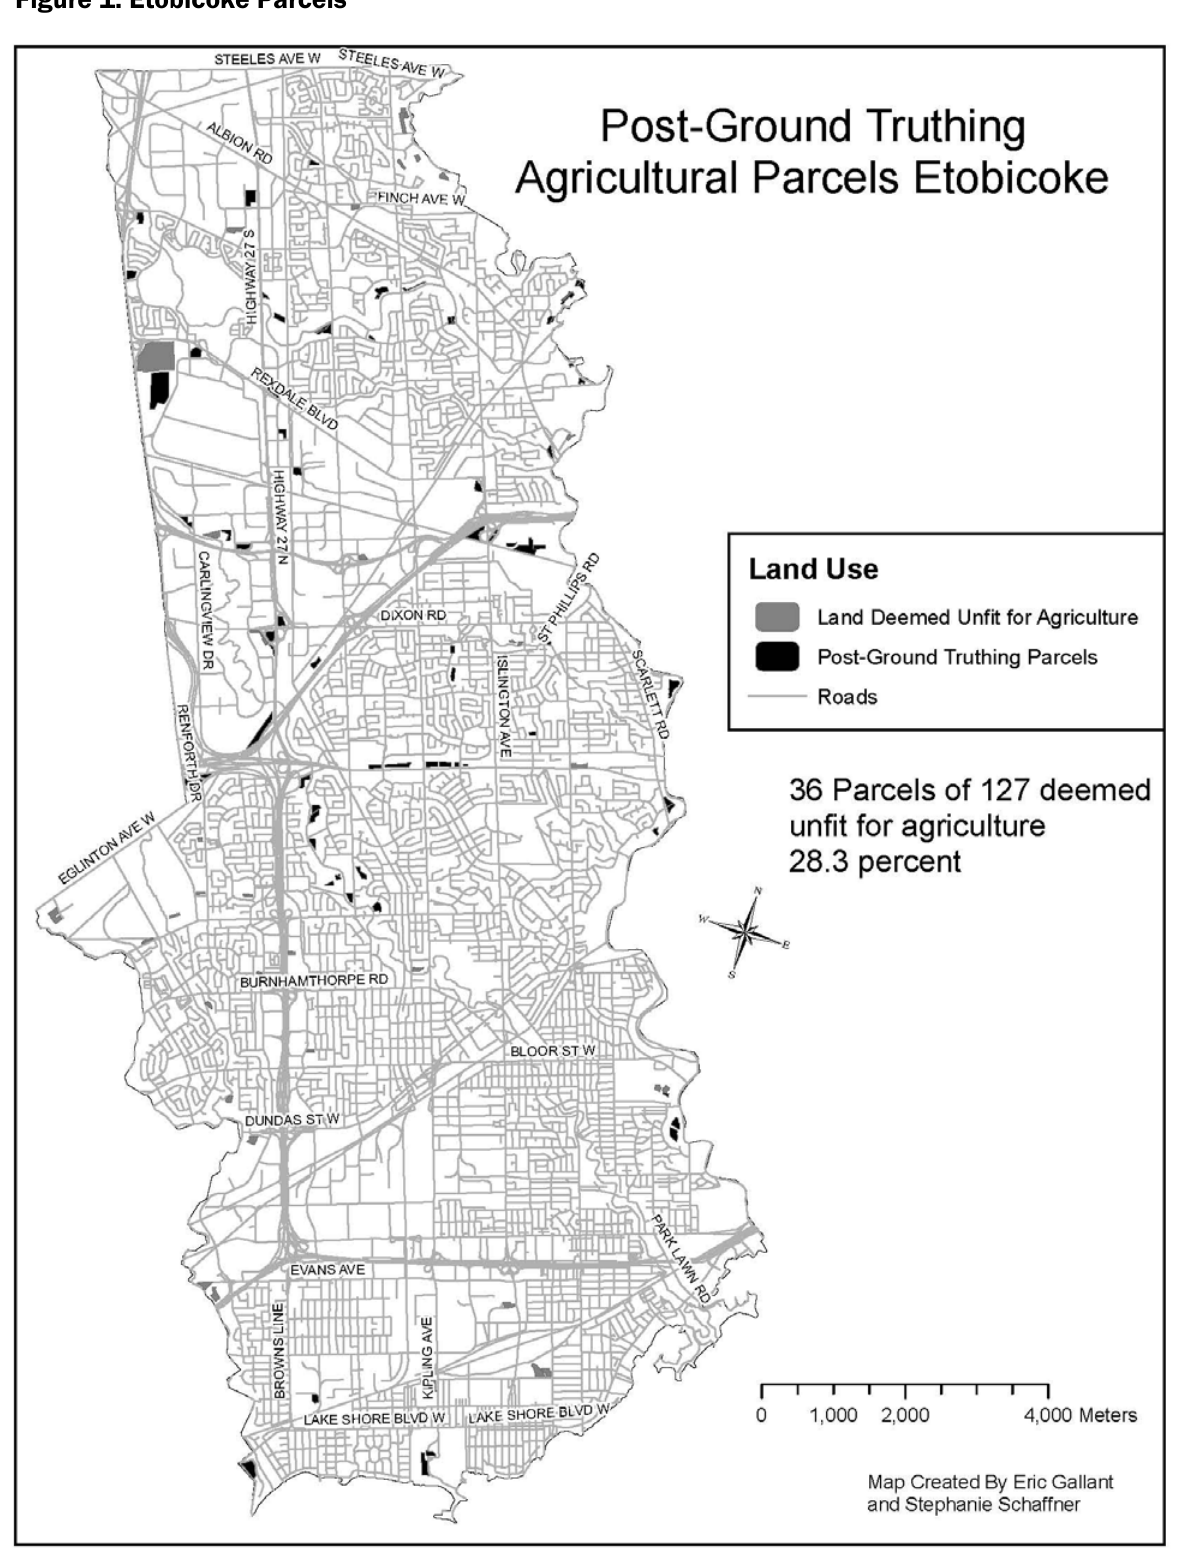
Figure 1. Etobicoke